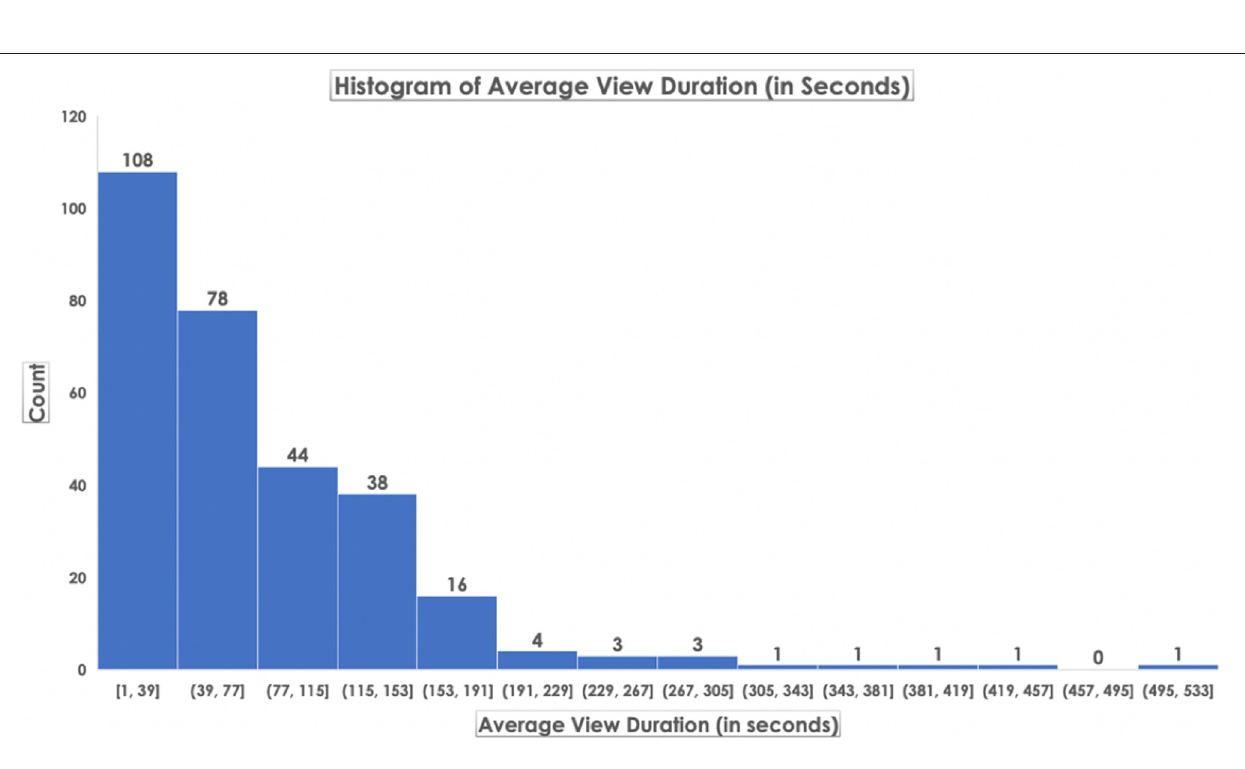
FIGURE 4 | Frequency of average view duration (in seconds in